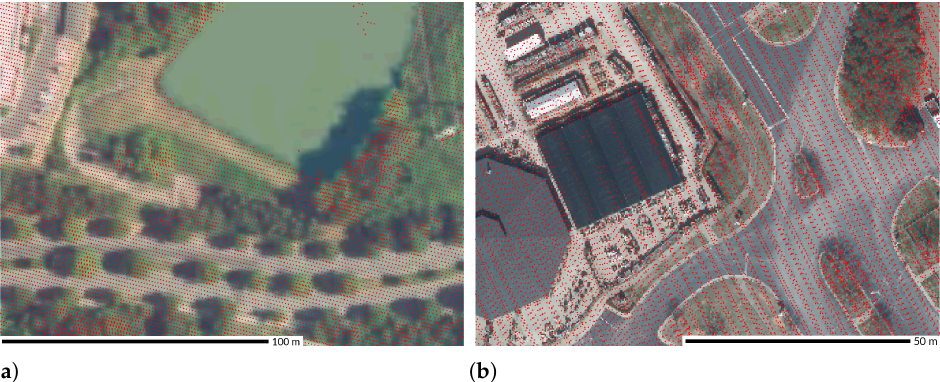
Figure 11. Areas without points caused by ( a ) a water body and ( b ) by a dark asphalt roof. Dataset: Wake County 2013